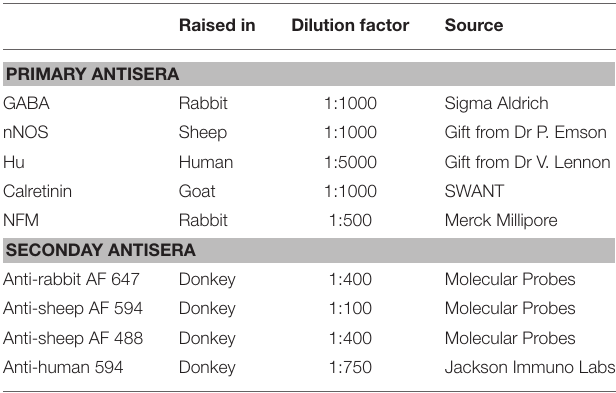
TABLE 1 | Primary and secondary antisera